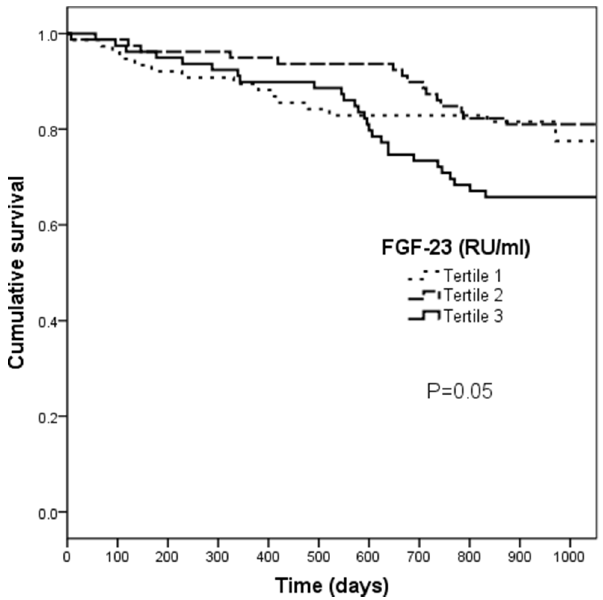
Figure 2. Cumulative survival by tertiles of Fibroblast growth factor 23 (FGF23). Patients were stratified by their FGF23 levels according to the tertiles. Kaplan-Meier analysis with long-rank test approached a significant difference between groups (P=0.05).